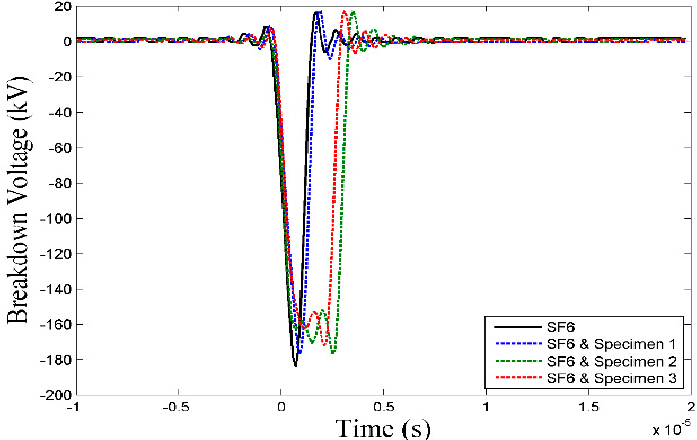
Figure 17. Lightning impulse discharge test results for negative polarity regarding SF 6 alone as well as in conjunction with open cell foam specimens of Table 4.